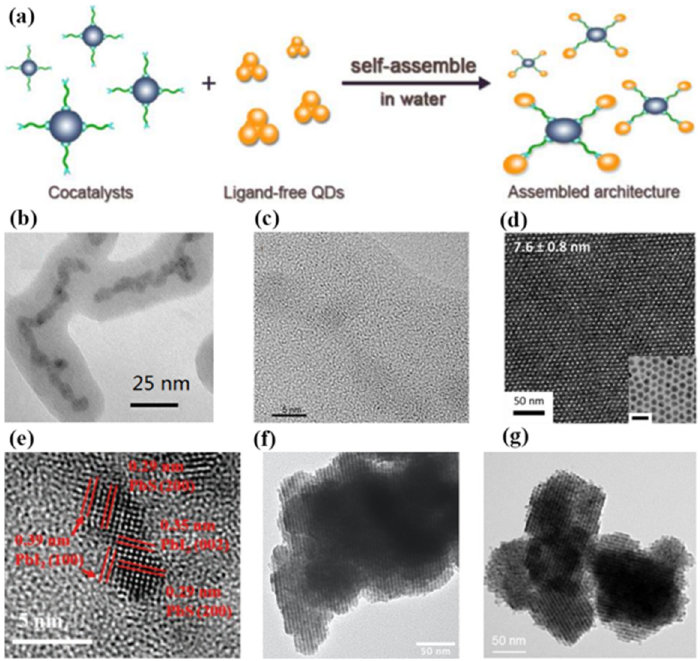
Figure 13. ( a ) Schematic illustration of the process of the self-assembled QDs by the ligand exchange method [74]. Copyright 2017, Journal Of The American Chemical Society . ( b , c ) TEM images of CdTe QD assembly in low magnification and high magnification [69]. Copyright 2015, Materials Research Bulletin . ( d ) TEM micrograph shows the HgTe QDs self-assembled by the ligand exchange method. The inset shows a monolayer of the same particles drop-cast from a dilute solution [70]. Copyright 2018, ACS Nano . ( e ) HRTEM image of the CQD-PbI 2 . The PbI 2 passivation layer was assembled between the CQDs [71]. Copyright 2021, Advanced Materials Interfaces . ( f ) Assembly results for 5 nm